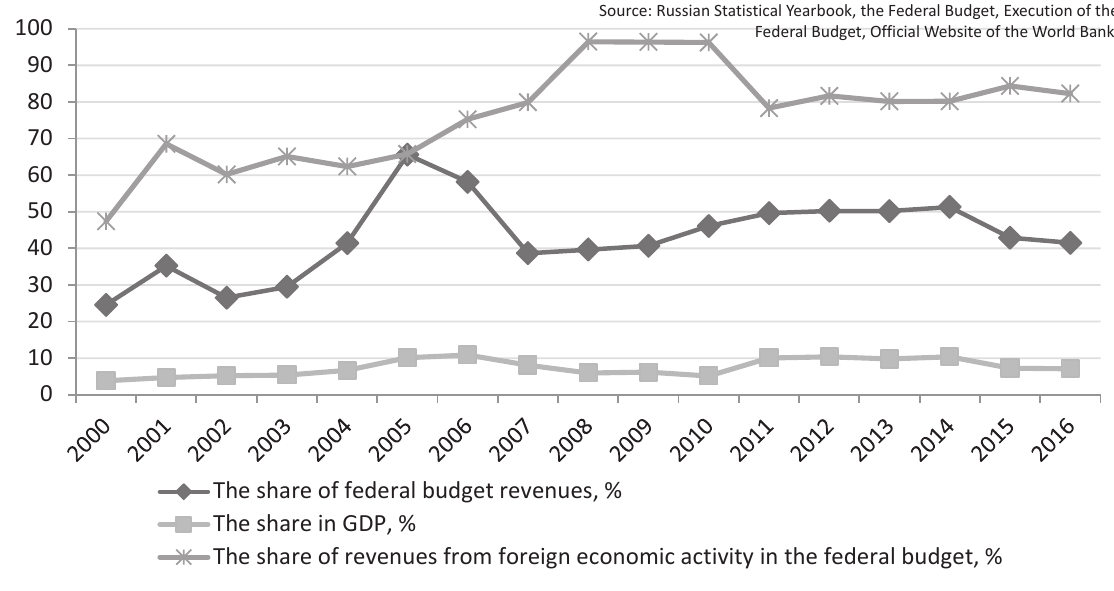
Figure 1. Macroeconomic indicators of the fuel and energy complex of Russia in